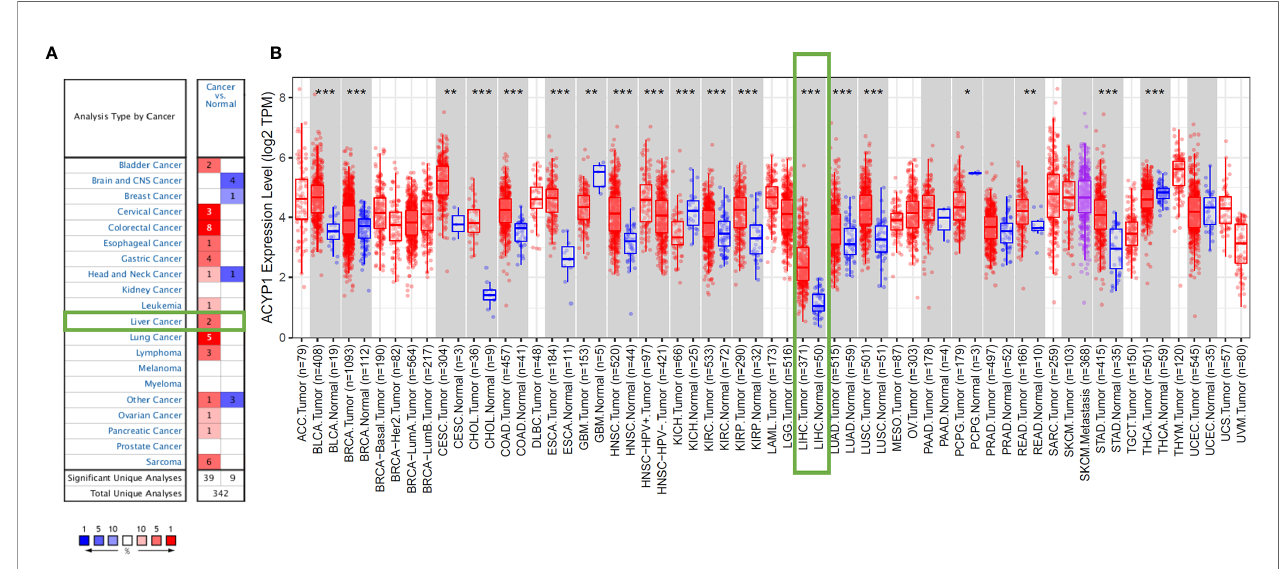
FIGURE 1 | ACYP1 expression levels across cancers. Elevated or decreased levels of ACYP1 expression in multiple cancer types in Oncomine (A) and TIMER (B) . *P < 0.05, **P < 0.01, ***P <